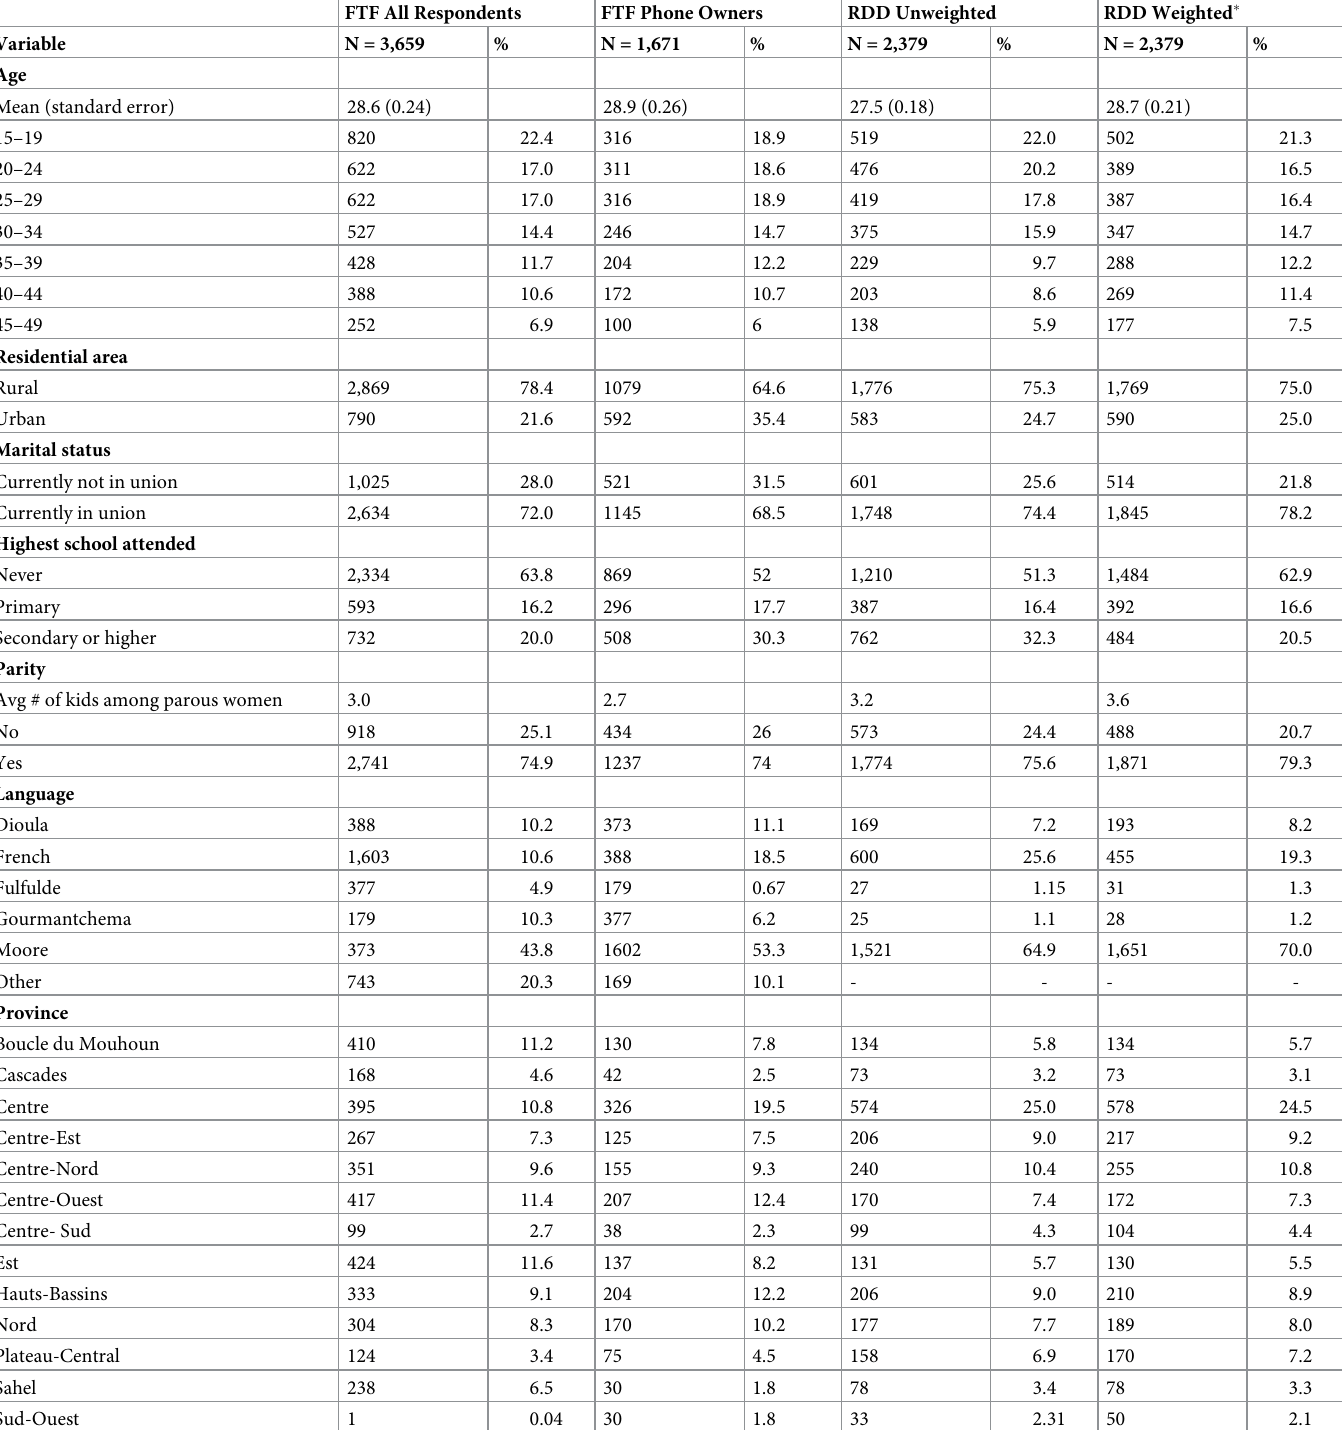
Table 4. Characteristics of women by survey mode and cell phone